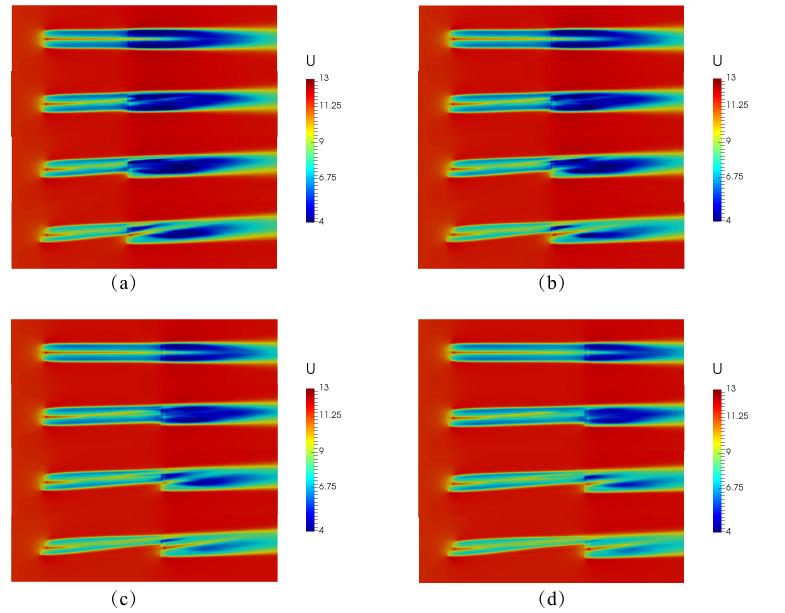
Figure 11. Contours of time-averaged velocity in the horizontal plane at hub height: ( a ) spacing = 5D; ( b ) spacing = 6D; ( c ) spacing = 7D; ( d ) spacing = 8D.